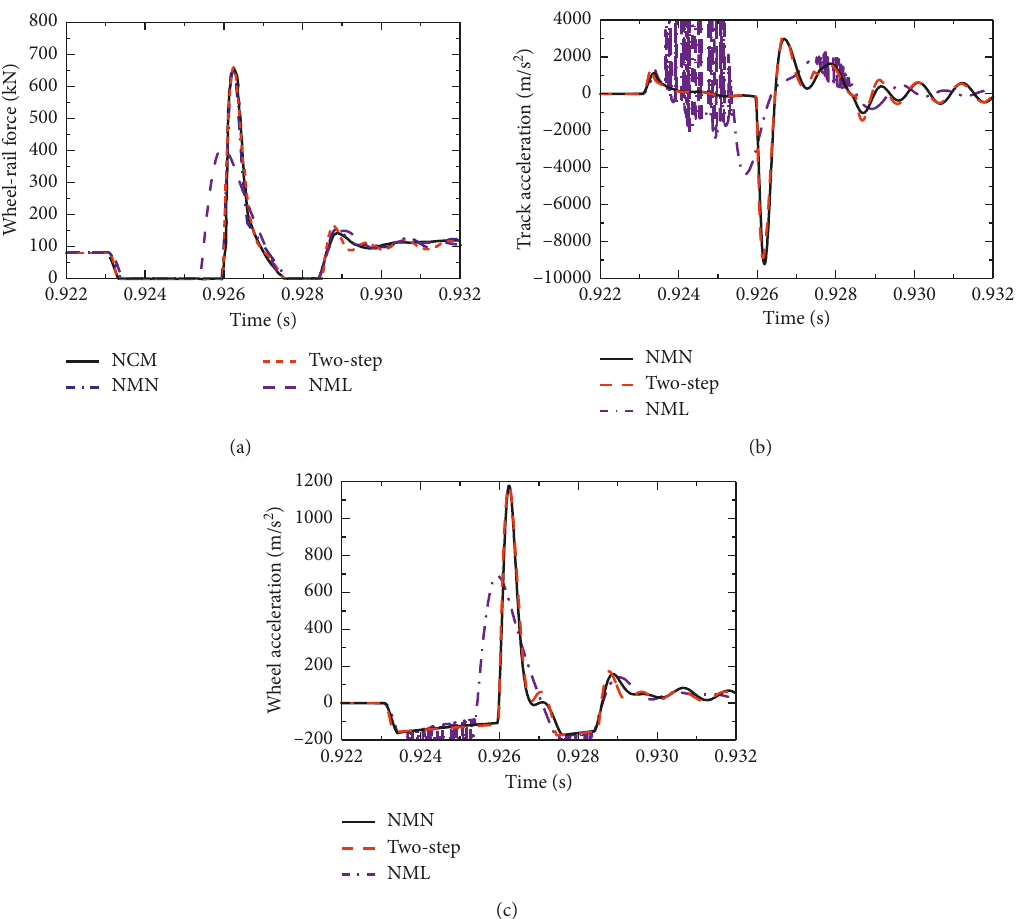
Figure 4: Responses of the vehicle-track system with a wheel flat: (a) wheel-rail force; (b) acceleration of the track; (c) acceleration of the wheel.